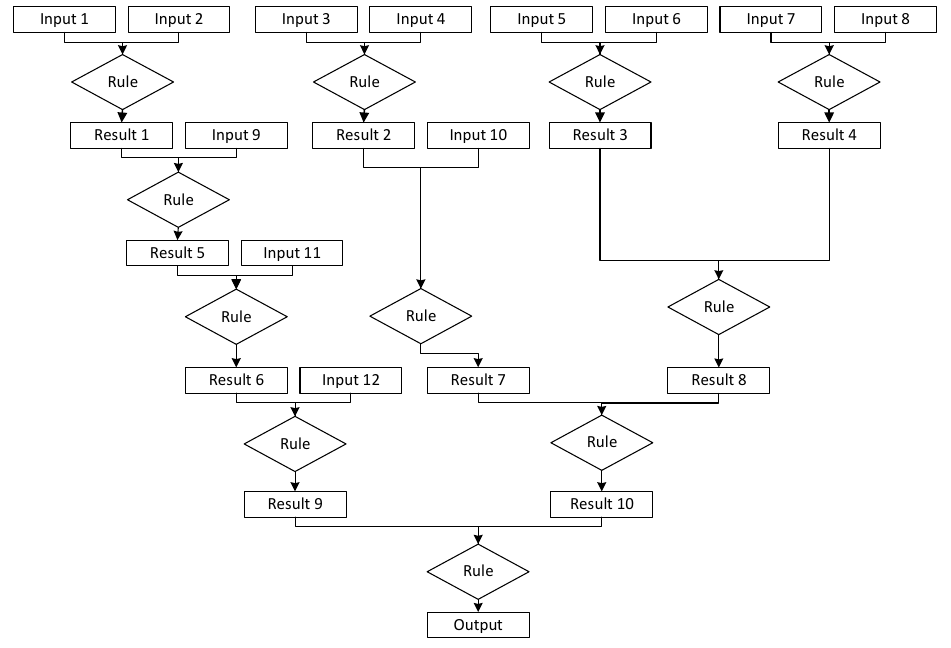
Figure 5. Logical design of Network 5.